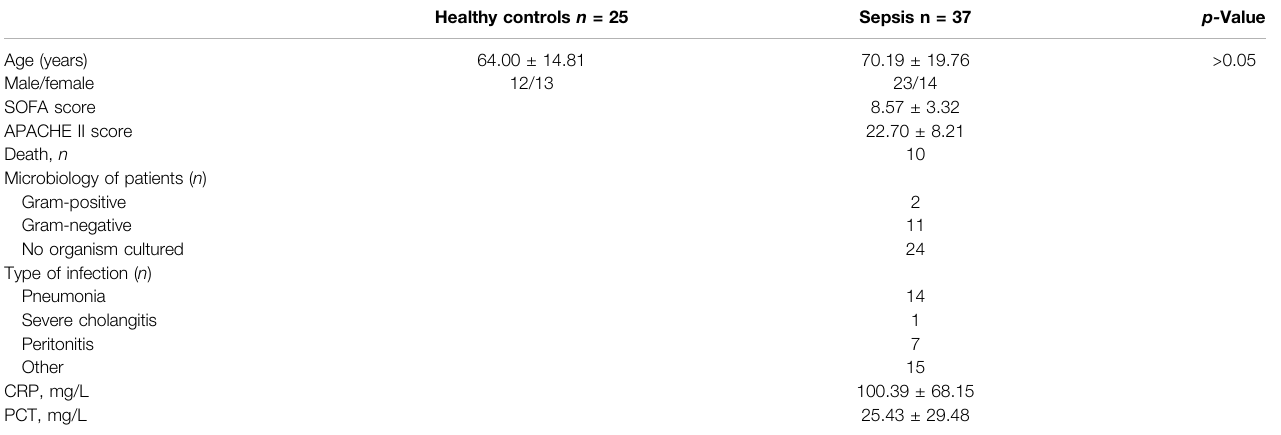
TABLE 1 | Demographic and clinical characteristics of sepsis patients in the validation